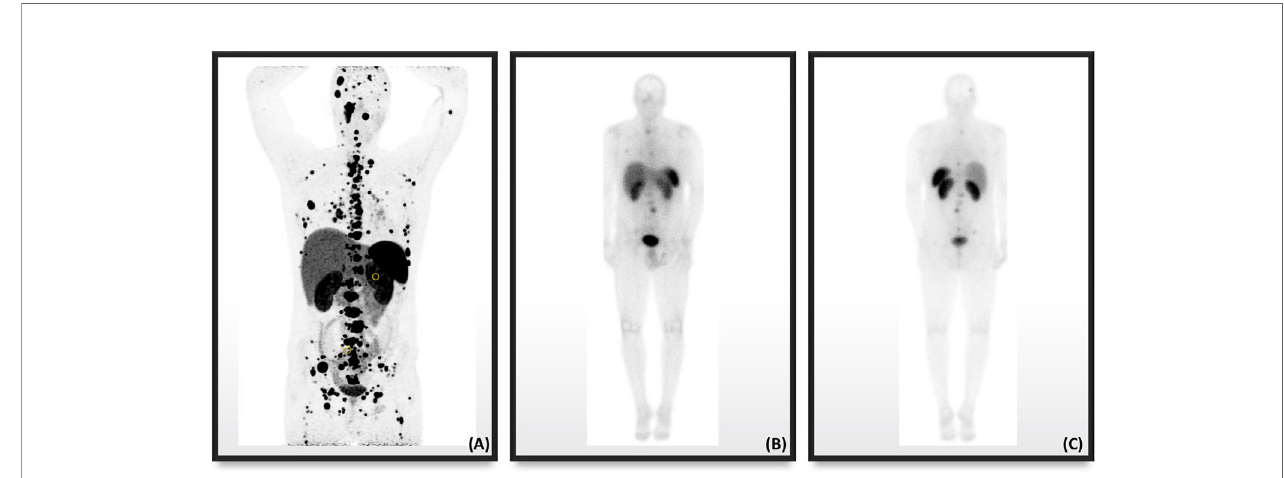
FIGURE 2 | Nuclear imaging in a male patient with metastatic PPGL in the setting of SDHD showing the superiority in resolution of (A) 68 Ga-DOTATATE PET/CT compared to Octreoscan ® in the (B) anterior anatomical plane and (C) posterior anatomical